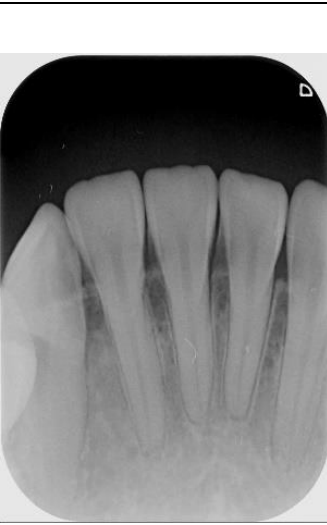
Table 5. Result after judgement for Figure 7 sample image.